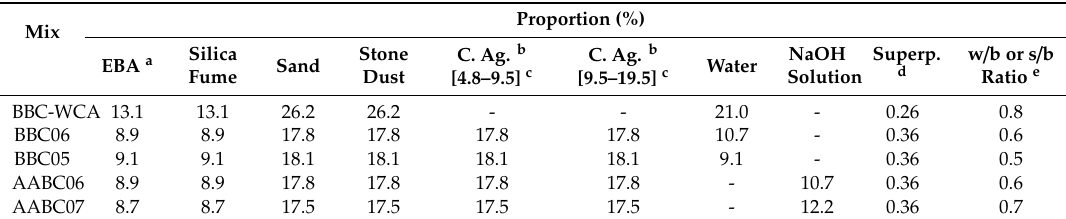
Table 2. Materials proportion design.